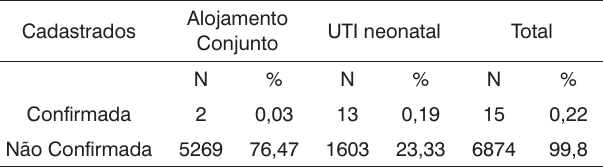
Tabela 3. Distribuição da Deficiência